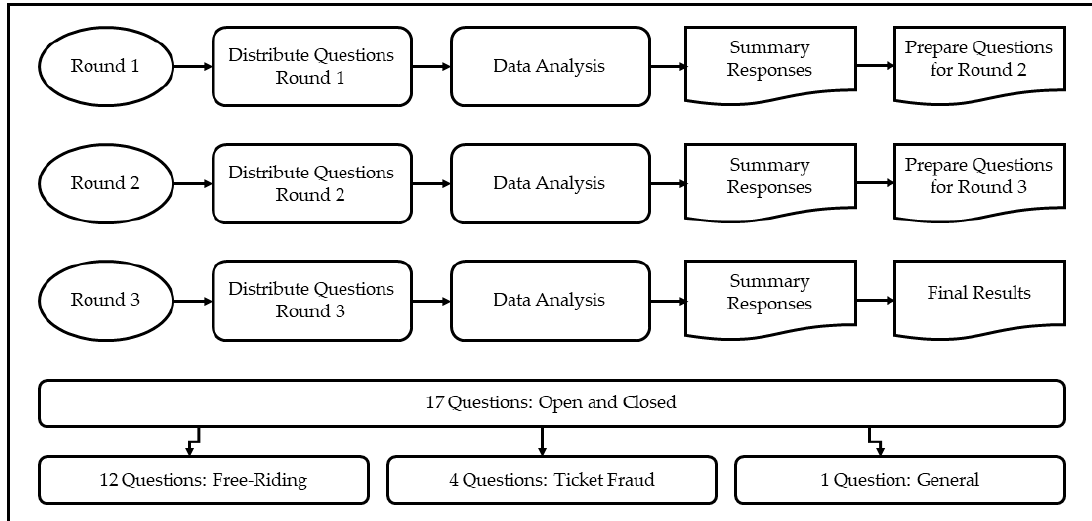
Figure 1. Delphi survey process.